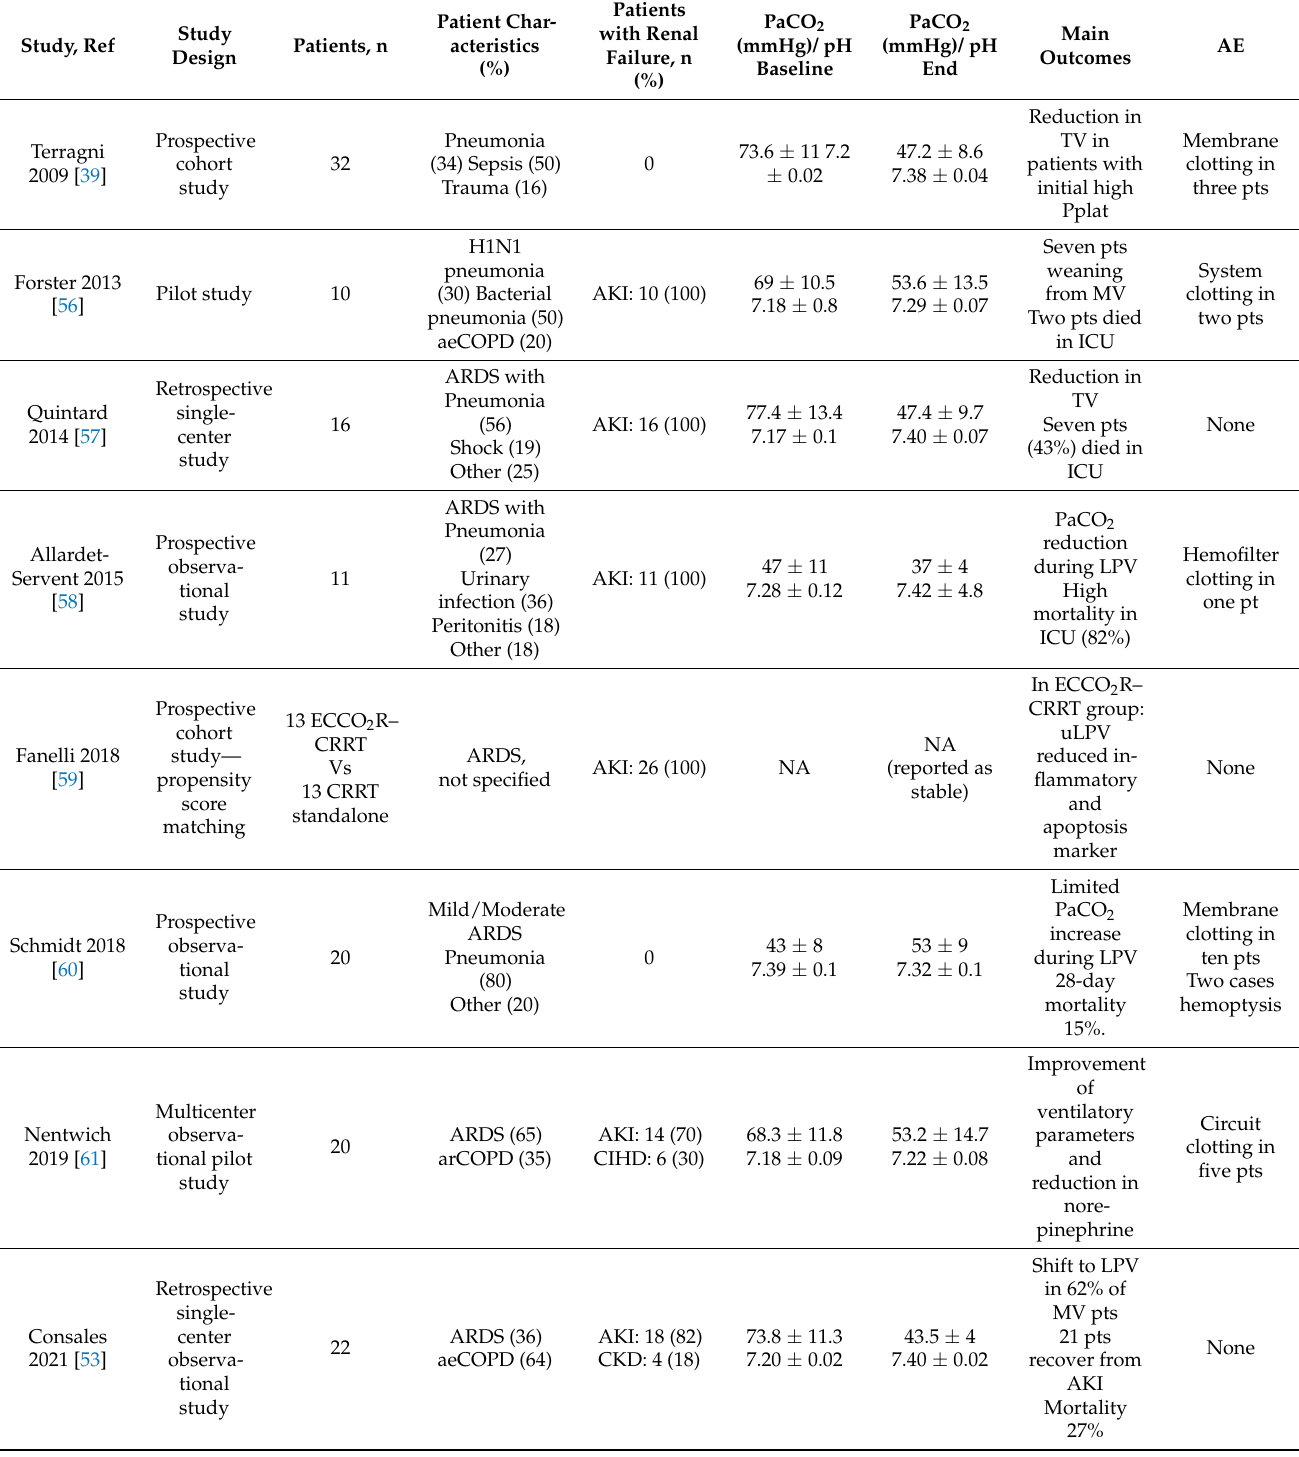
Table 1. Design, patient characteristics, and outcome of studies reporting use of combined ECCO 2 R– CRRT